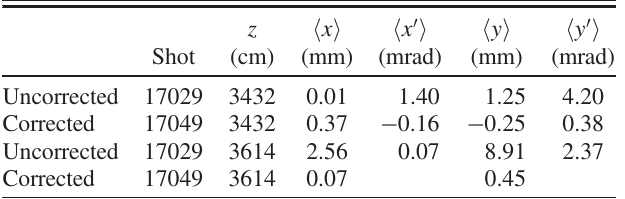
TABLE II. Measured beam centroid corrections using dipoles 33 ð x; y Þ and 36 ð x; y Þ after five cell blocks at BPM13 ( z ¼ 22 . 1 m) and after a drift through cells 41 – 44 at BPM14 ( z ¼ 24 . 3 m).